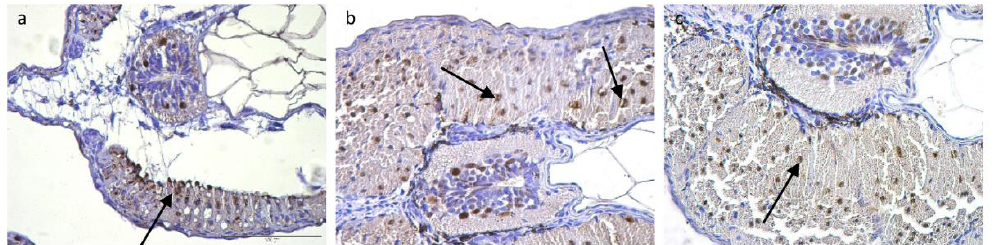
Figure 6. Representative images of PCNA-immunolocalization (arrows) at different timepoints: ( a ) T0; ( b ) T1, BB1; ( c ) T2, CTR. Scale bar: 100 µm.